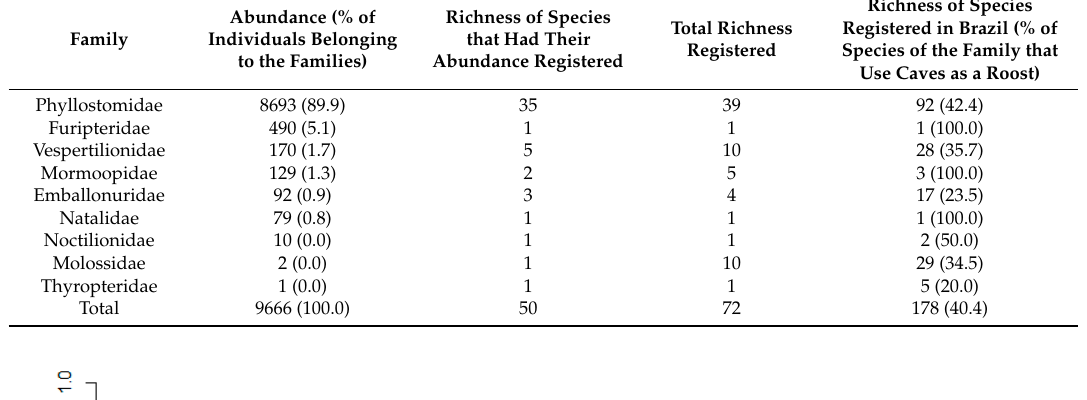
Figure 1. Richness of cave-dwelling bats in the Brazilian biomes. Vertical lines: Amazon; White: Brazilian savanna; Diagonal lines: scrub forest; Light gray: wetlands; Dark gray: Atlantic forest; Horizontal lines: grasslands.